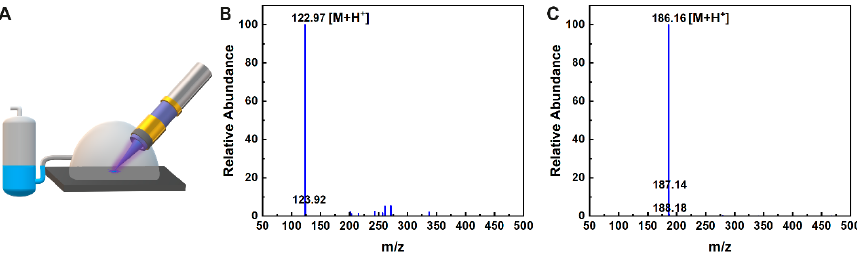
Figure 3. ( A ) Experimental setup for collecting vapor phase above a contaminated glass surface sampled with LTP probe. After sampling, the collecting-solvent is analyzed using an LC-MS. ( B ) LC-MS analysis of nicotinamide and of ( C ) dodecylamine.